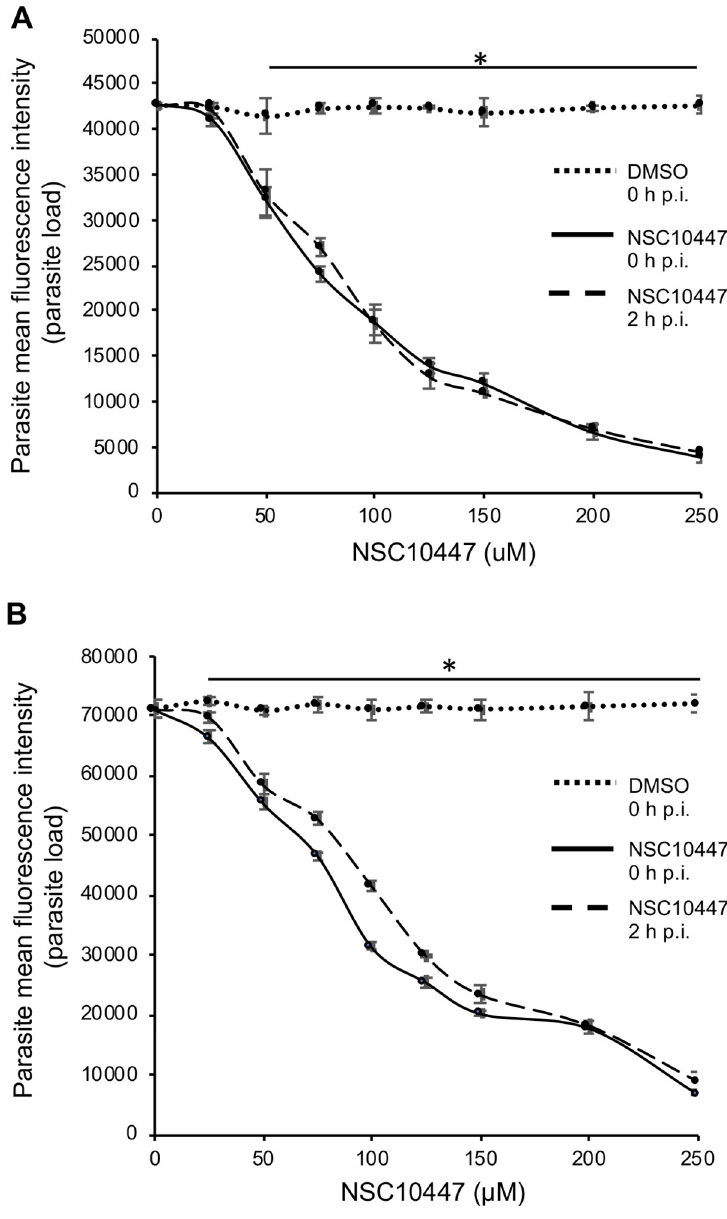
Fig 5. Analysis of the effect of varying concentrations of compound NSC10447 on the growth of Cryptosporidium parvum in HCT-8 cells. Equal amounts of freshly excysted sporozoites of C . parvum were inoculated into HCT-8 cells in culture and varying concentrations of NSC10447 added at the time of infection (solid line) or added 2 h post- infection (p.i.) (dashed line). Control infected cells (dotted line) were treated immediately p.i. with volumes of DMSO equivalent to those used in the compound-treated cultures. The cultures were analyzed for parasite infectivity and proliferation by an immunofluorescence assay after (A) 48 h, and (B) 72 h of culture. The fluorescence generated by intracellular C . parvum merozoites was quantified and is shown on the Y -axis representing the parasite load. The data shown represent means of three independent experiments with standard error bars and levels of statistical significance between groups indicated by asterisk ( � , P < 0.05). highest tolerable doses in mice for the two compounds were found to be 400 mg/kg and 1000 mg/kg for NSC158011 and NSC10447, respectively. These doses consistently did not induce